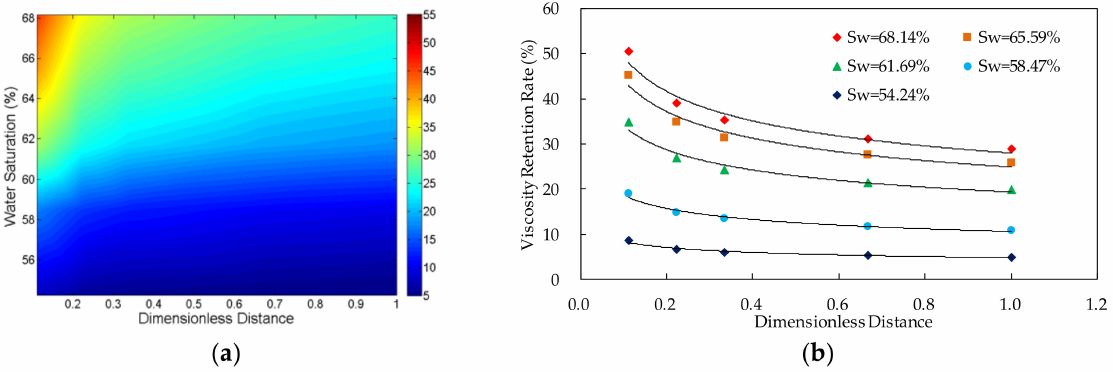
Figure 5. The relationship between viscosity retention rate of polymer solution, dimensionless dis- tance and water saturation in the experiment VV-3 in which the polymer concentration is 1750 mg/L. ( a ) Contour map of viscosity retention rate; and ( b ) scatter plot of viscosity retention rate.